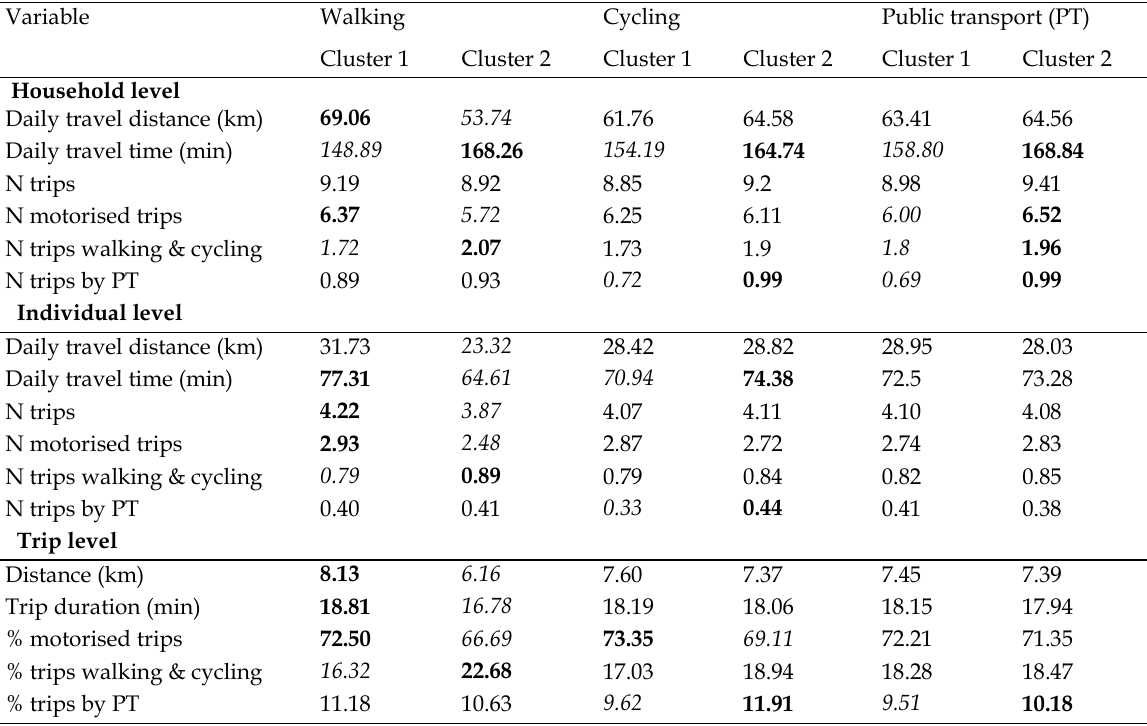
Note: Bold and italic values indicate the largest and smallest values for statistically significant comparisons at 0.05